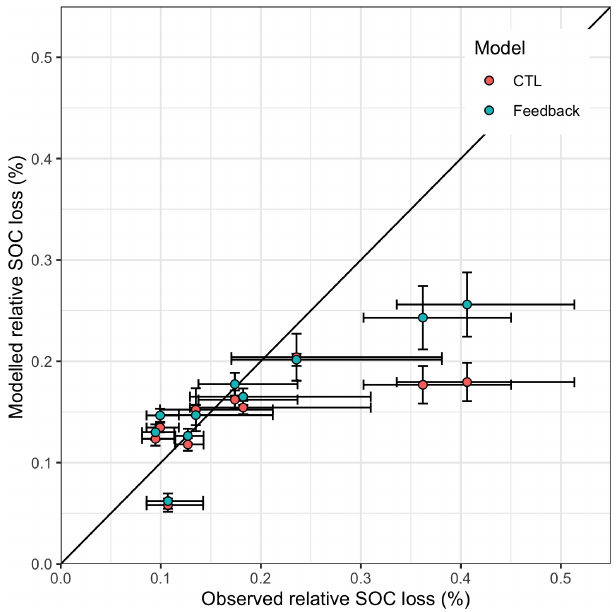
Figure 4. Modelled against observed relative SOC losses. Colours denote the different datasets: control dataset (CTL, red) and the dataset including the effect of erosion on productivity (FB, blue). Error bars represent 1 standard deviation from the mean for both observed and modelled